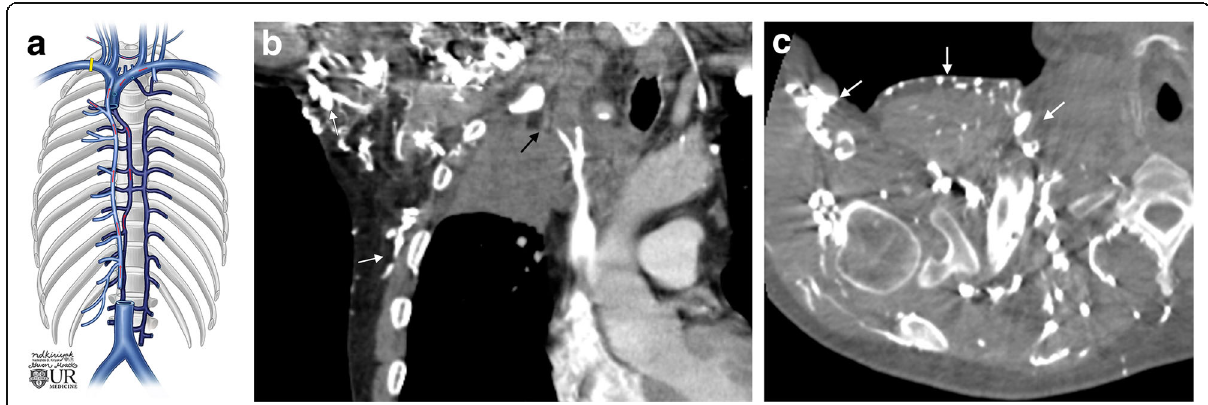
Fig. 5 Shoulder/chest wall collaterals. a Schematic image of a subclavian obstruction and pathway for collateral flow. b Coronal CT image in a 53-year-old patient with a right apical lung mass (stage IV lung adenocarcinoma) obstructing the subclavian venous flow (black arrow) due to mass effect. Extensive shoulder and chest wall collateral formation (white arrows). c Axial CT image in the same patient shows extensive unnamed shoulder and chest wall collaterals (white